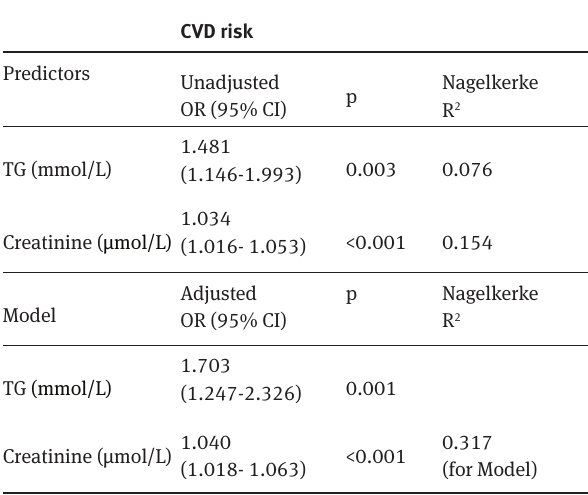
Table 4: Odds ratios (OR) after univariate and multivariate logistic regression analysis for parameters predicting abilities regarding